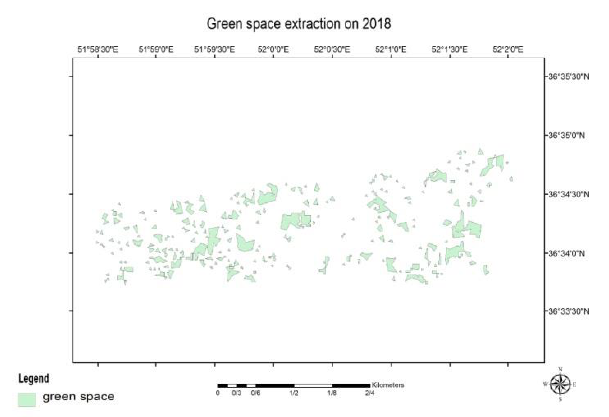
Figure5. Green space extraction in 2018